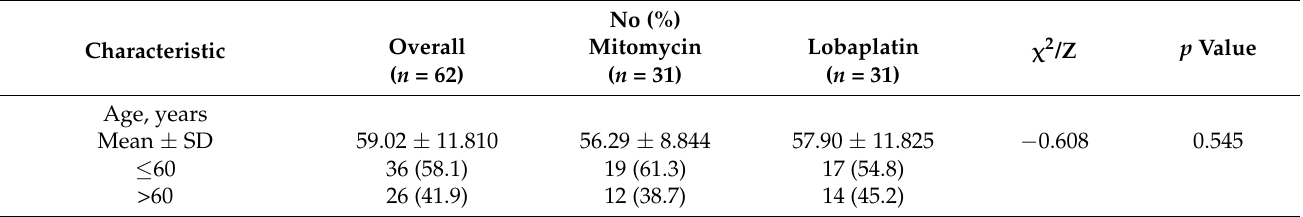
Table 2. Baseline clinicopathological characteristics of patients with T4 colorectal cancer after PSM.